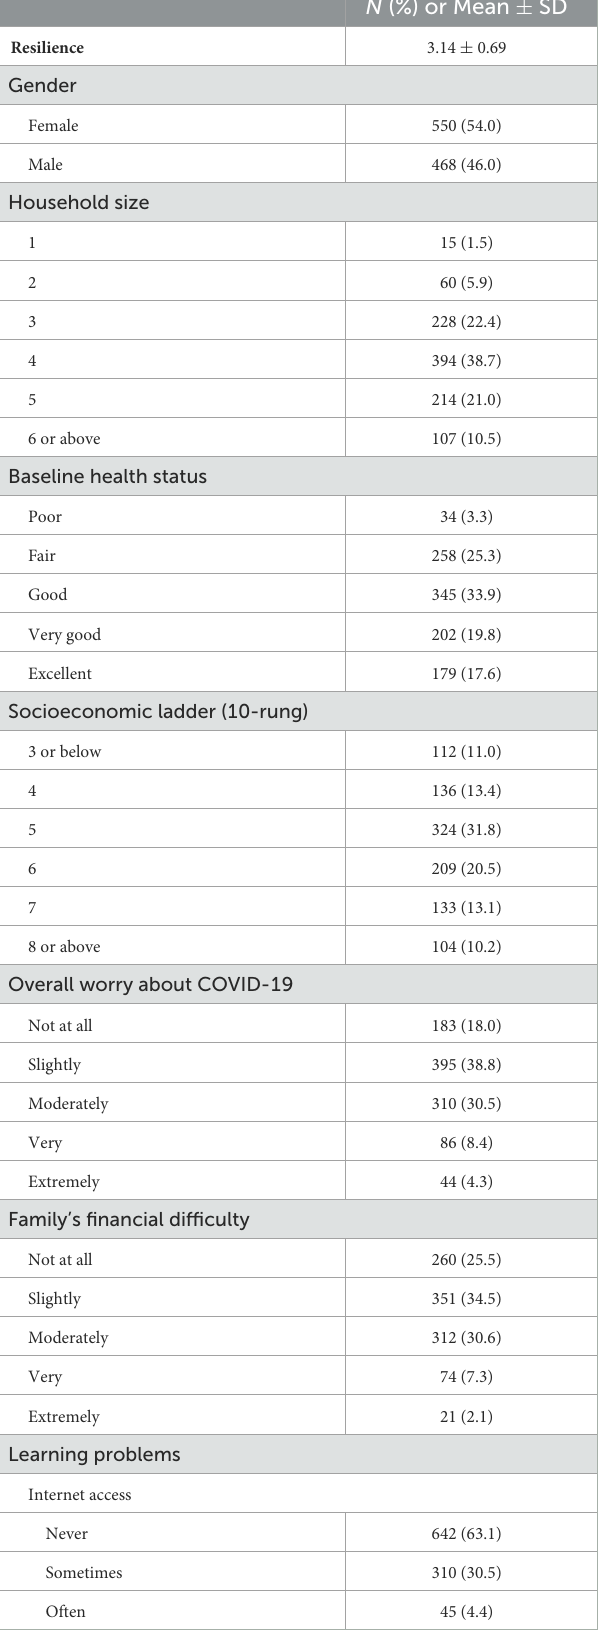
TABLE 1 Basic characteristics of respondents ( n =